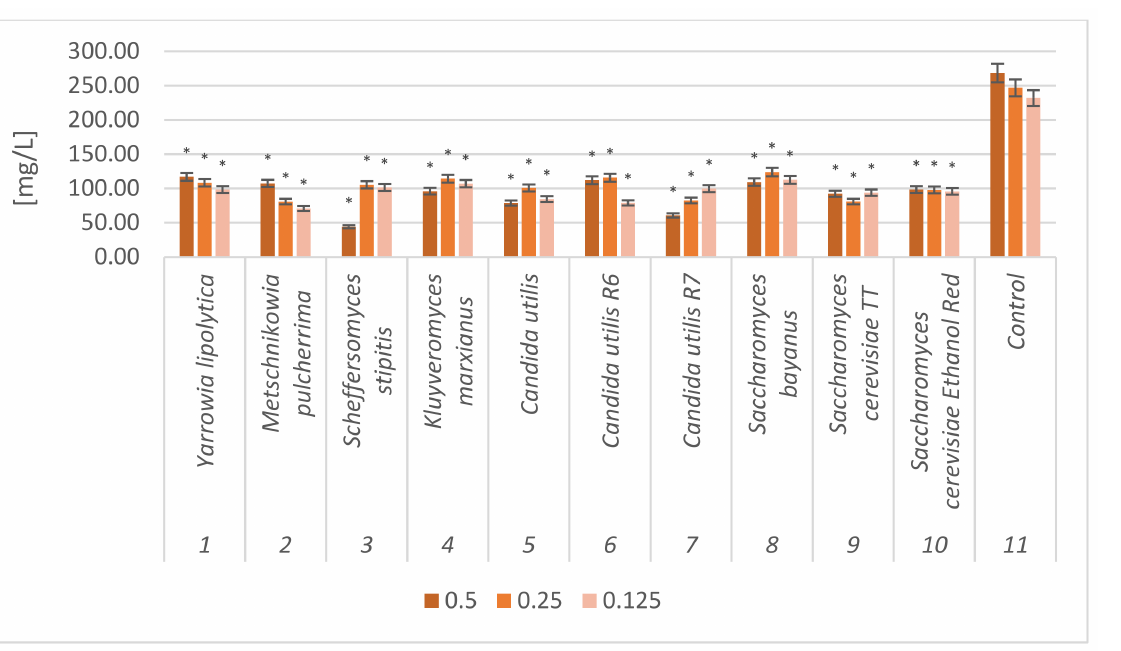
Figure 4. Free amino nitrogen (FAN) content in fresh sugar beet pulp samples after yeast cul- tivation. The biomass was hydrolyzed with different enzyme concentrations (0.5 mL/10 g DM; 0.25 mL/10 g DM; 0.125 mL/10 g DM); *—indicator of statistical difference relative to the control sample ( p <